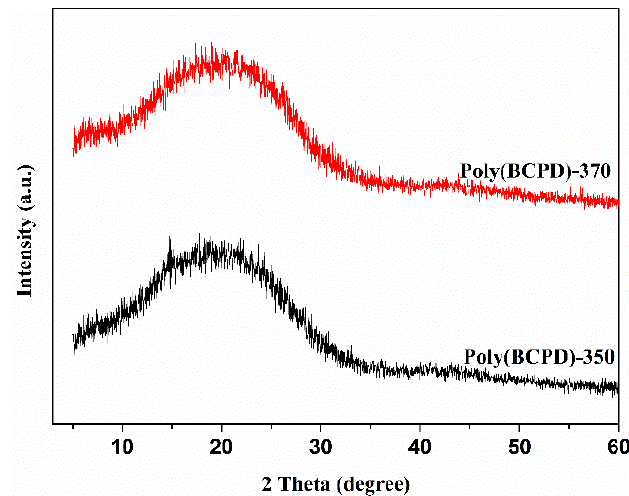
Figure 9. WAXD curves of the poly(BCPD) resins.